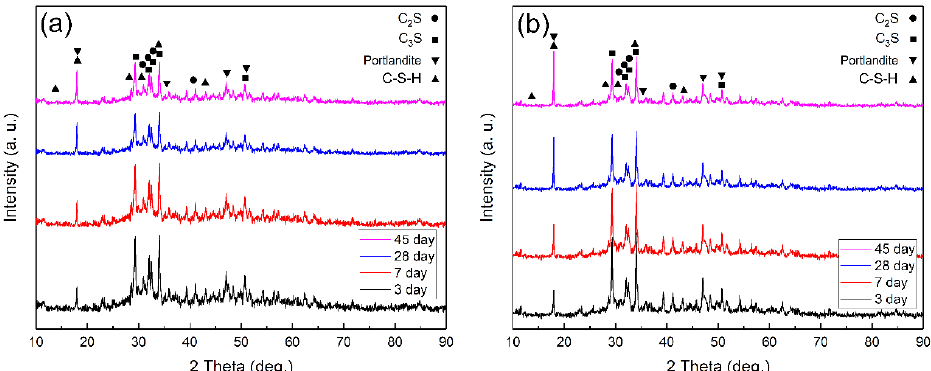
Figure 9. XRD patterns of cement pastes at 3, 7, 28, and 45 days with different nanohybrids: ( a ) 0 wt% and ( b ) 3 wt%. and ( b ) 3 The 2 θ peaks of 32.1°, 32.45°, 51.75°, 29.3°, and 34.2° are the most intense peaks related